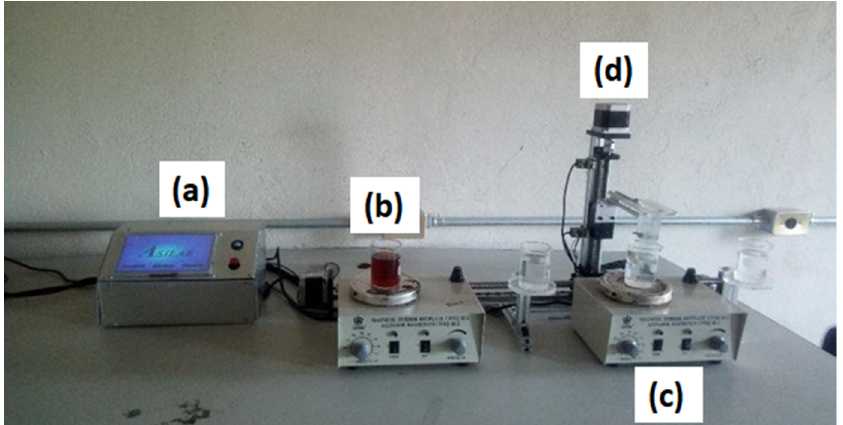
Figure 16. Automated SILAR prototype in operation: HMI and electronic module ( a ), vessels ( b ), units of magnetic stirrer with heating plate ( c ), and mechanical elements ( d ).